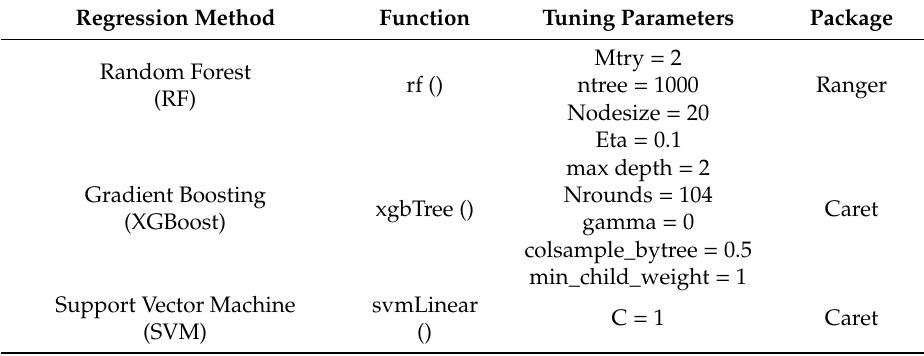
Table 4. Machine Learning Methods’ Tuning